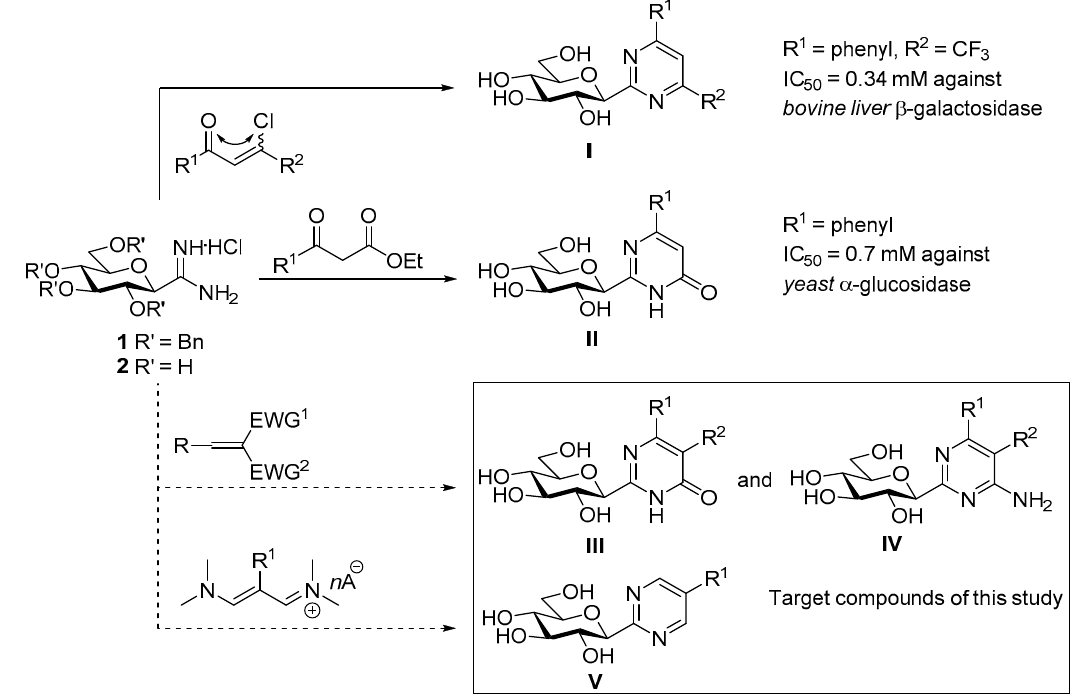
Figure 1. Recent syntheses of 2- C -glucopyranosyl pyrimidines yielding biologically active derivatives and the target compounds of this study.